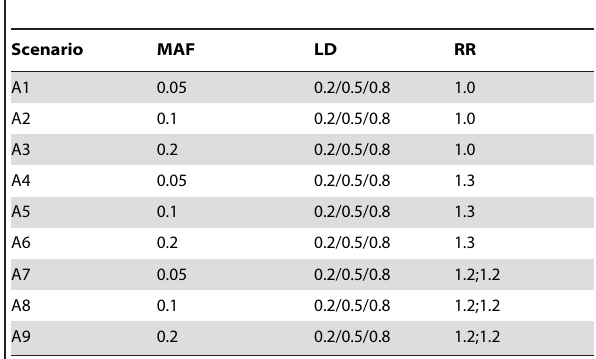
Table 1. Parameter settings of virtual datasets.